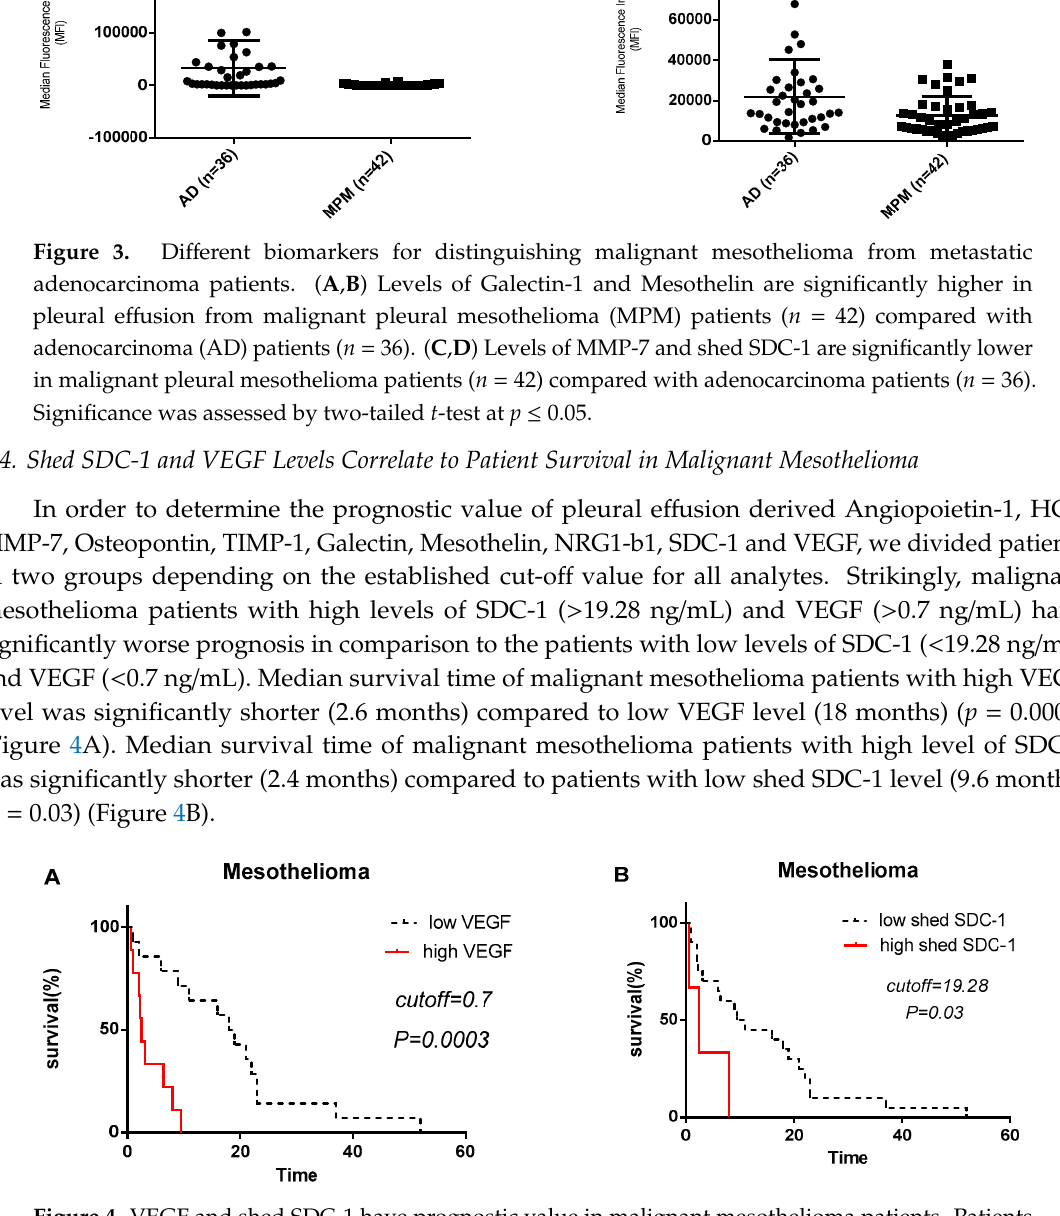
Figure 3. Different biomarkers for distinguishing malignant mesothelioma from metastatic adenocarcinoma patients. ( A , B ): Levels of Galectin-1 and Mesothelin are significantly higher in pleural effusion from malignant pleural mesothelioma (MPM) patients ( n = 42) compared with adenocarcinoma (AD) patients ( n = 36). ( C , D ): Levels of MMP-7 and shed SDC-1 are significantly lower in malignant pleural mesothelioma patients ( n = 42) compared with adenocarcinoma patients ( n = 36). Significance was assessed by two-tailed t-test at p ≤ 0.05.